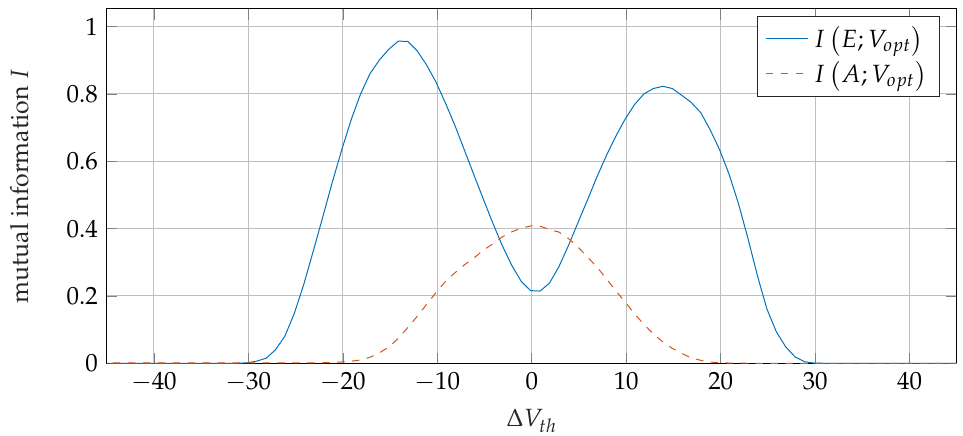
Figure 7. Mutual information between number of errors or the binary variable A and optimal threshold voltage for reference r 3 over read voltage.